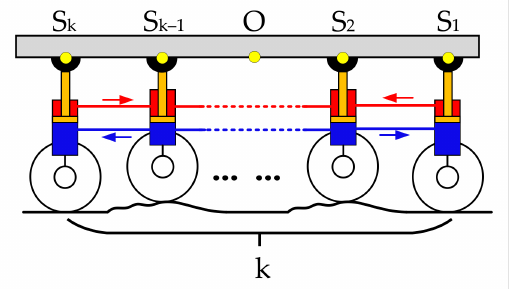
Figure 3. Hydro-pneumatic balance suspension of multi-axle